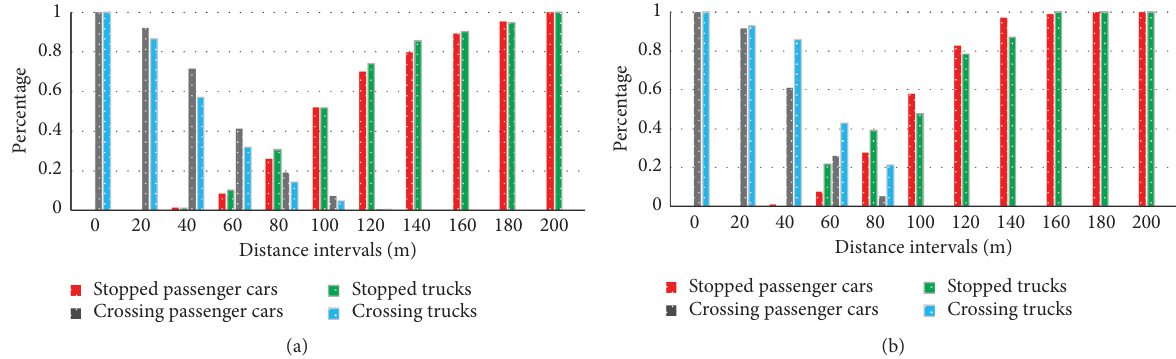
Figure 3: Distributions of stop/go decisions for distance interval from intersections. (a) Rural intersections and (b) urban